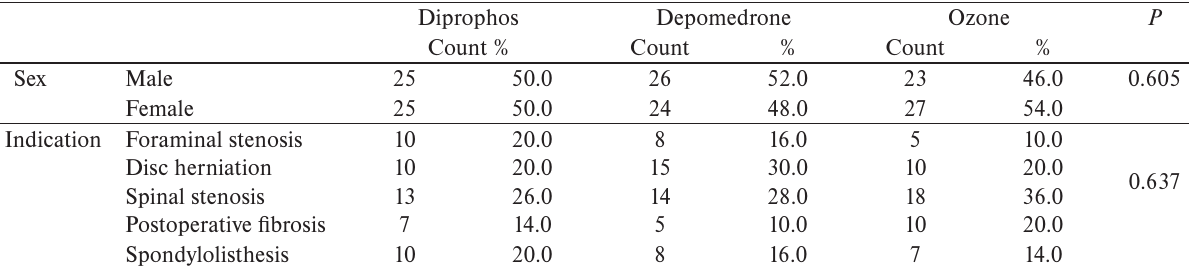
Table 2. Sex and indication characteristics of the individual groups.